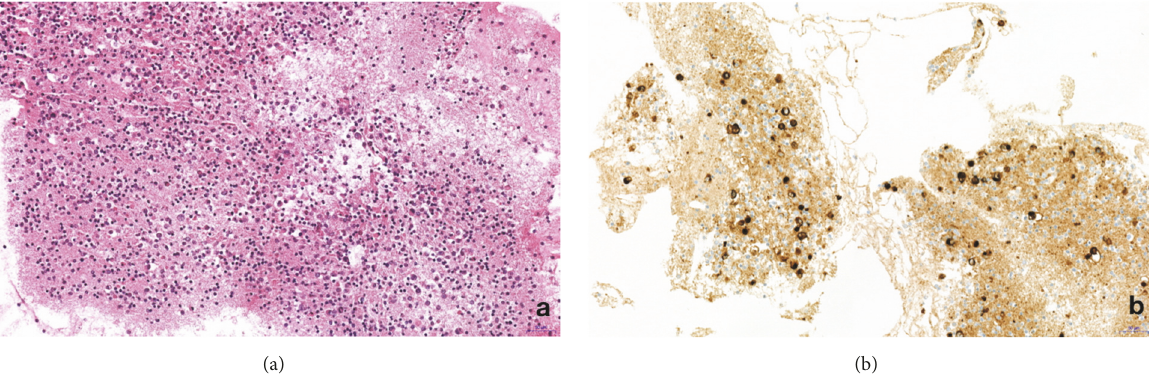
Figure 5: Case 2, (a) H&E section of the cell block preparation from effusion fluid showing atypical lymphocytes; (b) CD30 immunohistochemistry highlights tumor cells positive for CD30 (original magnification